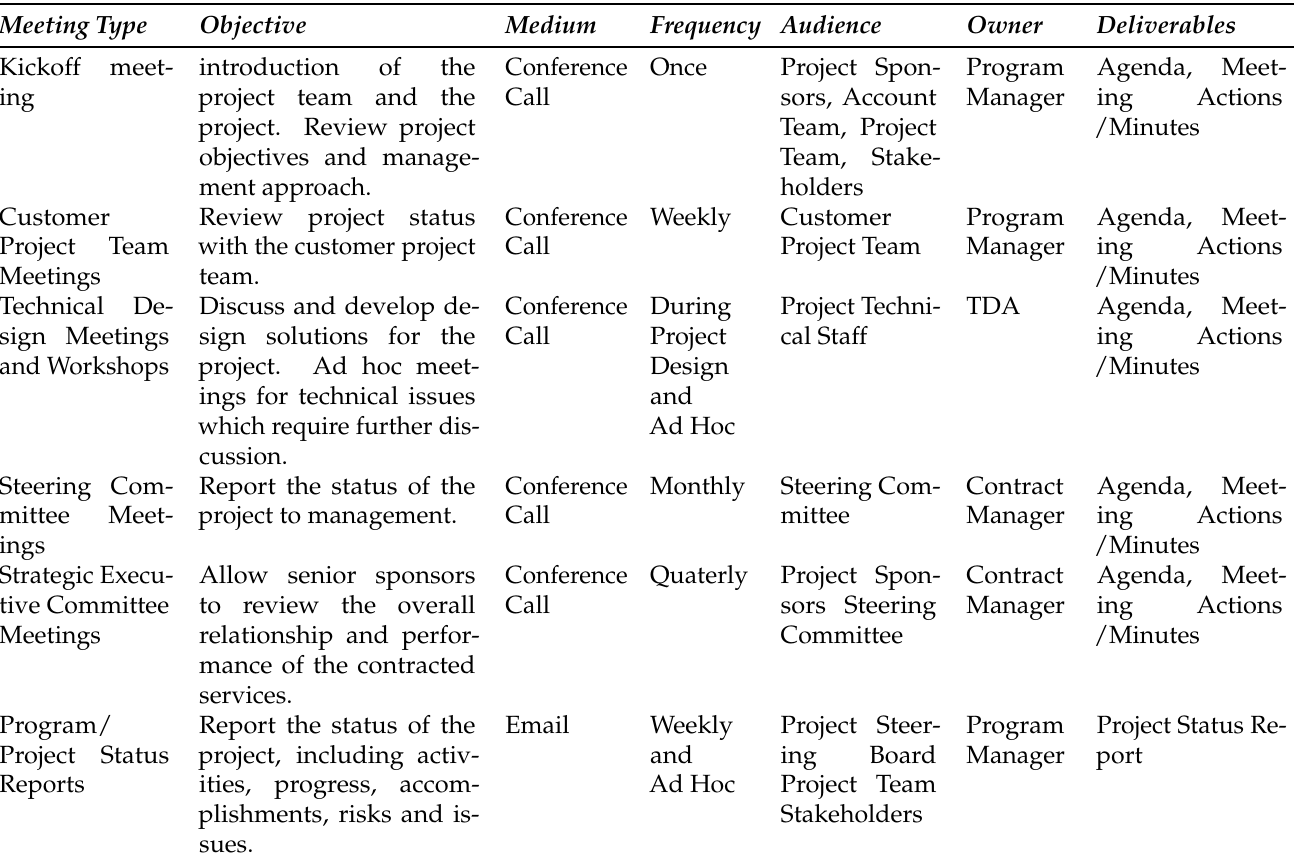
Table 10. Communications